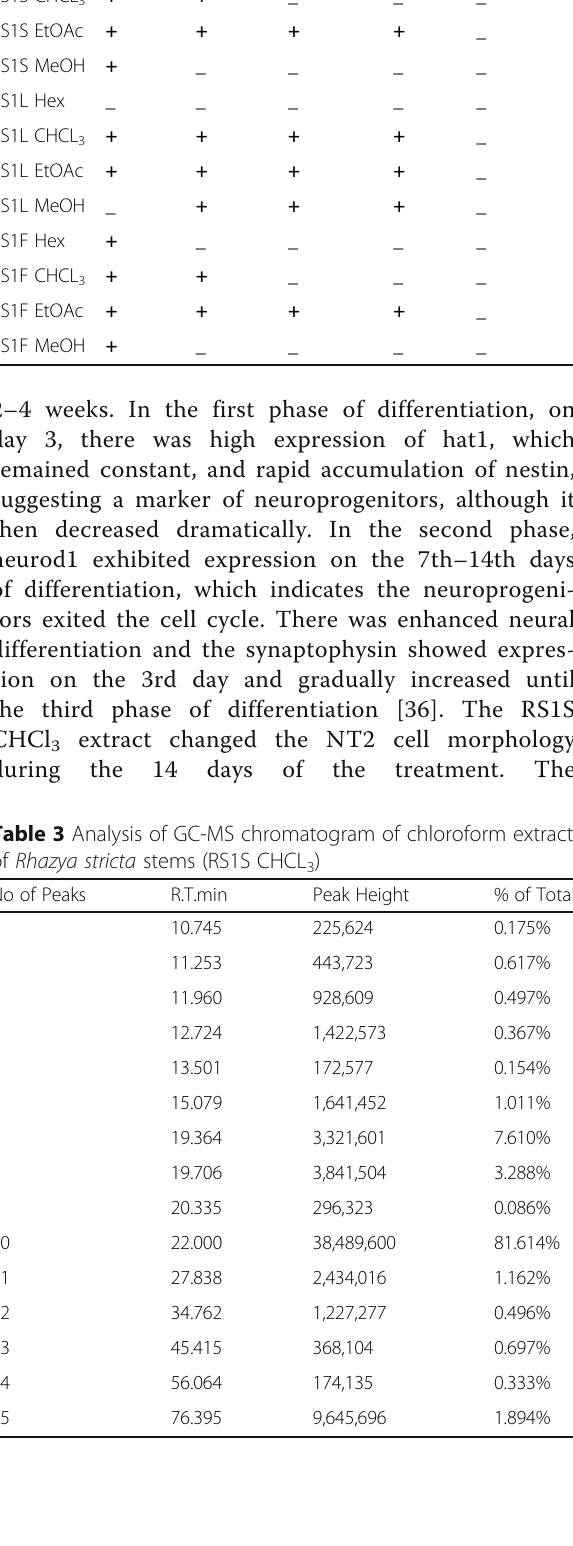
Table 2 Phytochemical compounds present in R. stricta extracts. (+) denotes presence of phytochemical compound, ( − ) denotes absence of phytochemical compound Extract Alkaloids Saponins Flavonoids Phenols Amino acids RS1S Hex